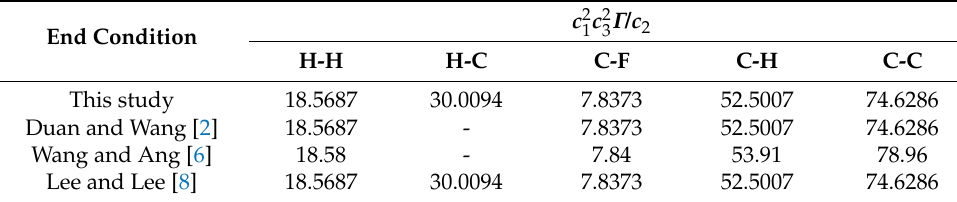
Γ / c = 1 *. c 2 2 for n 3 1